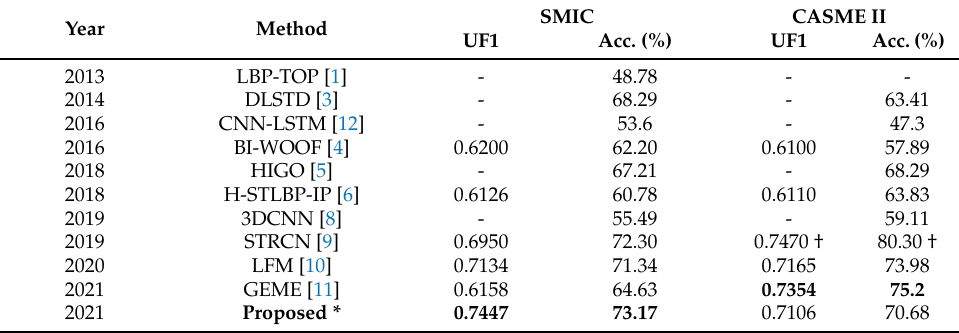
Table 2. Comparison to other methods on SMIC and CASME II.